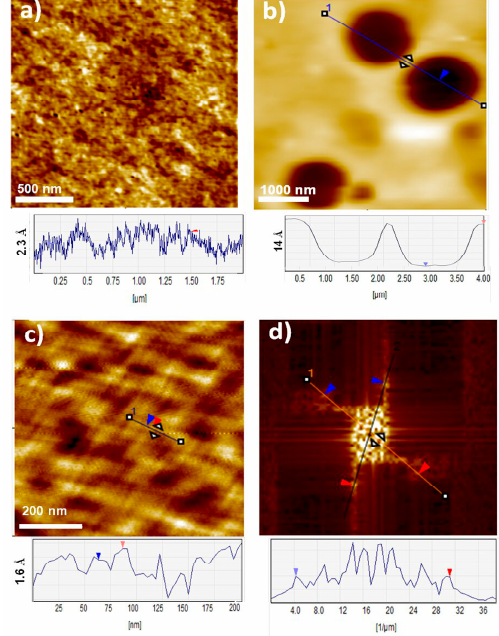
Figure 7. Atomic force microscopy height images and cross-sectional analysis of ( a ) LPSQ-triazole-Py; ( b ) POSS-triazole-Py thin films cast on silicon supports; ( c ) LPSQ-triazole-Py image after ( d ) FFT spectrum analysis .